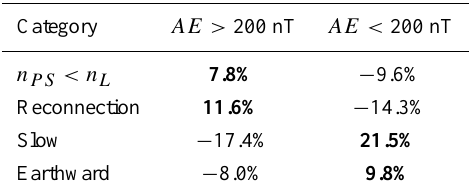
Table 5. Distribution of plasma sheet encounters with respect to the